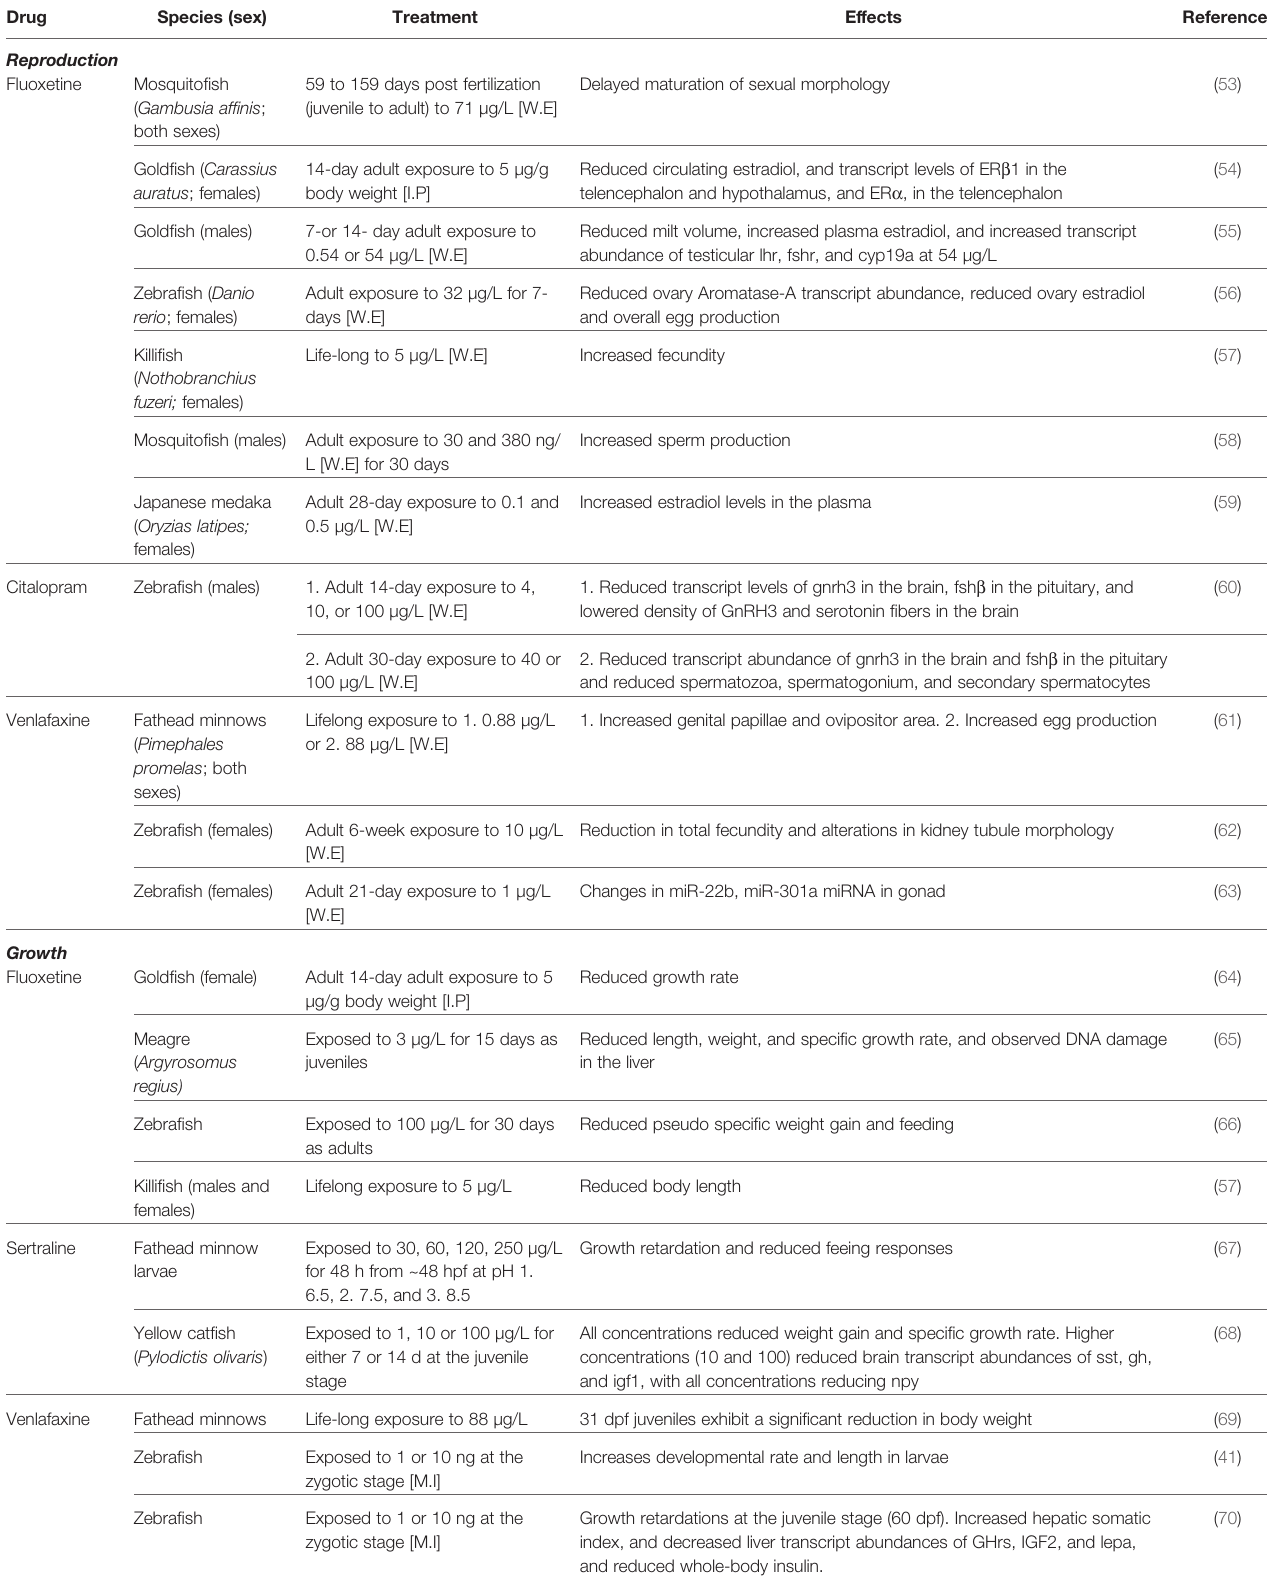
TABLE 1 | Evidence of endocrine impacts of antidepressants in fi